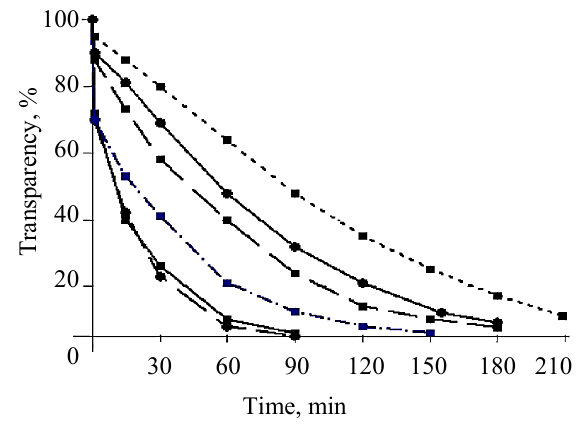
Fig. 2. Transparency of solutions depending on the type of seed crystals at a temperature of 60°C and an excess concentration of Δ C = 60 g/100 g of water (from top to bottom): - – - – a seed from large (> 200 microns) commercial hydrate glucose crystals; ______ a seed from small (< 60 microns) commercial anhydrous glucose crystals; __ __ a seed from small (< 60 μm) anhydrous glucose crystals with propanol; __ . __ a seed from small (< 60 microns) commercial hydrate glucose crystals; _____ a seed from large (> 200 μm) hydrate glucose crystals with propanol; __ __ a seed from small (< 60 μm) hydrate glucose crystals with